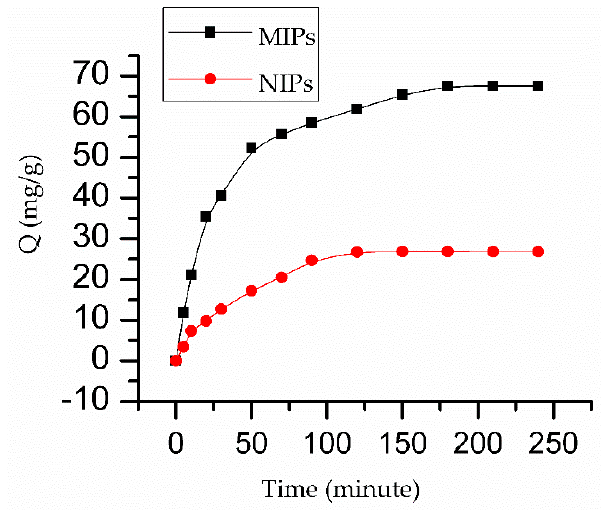
Figure 10. The adsorption kinetics of SSO-MIPs and NIPs.